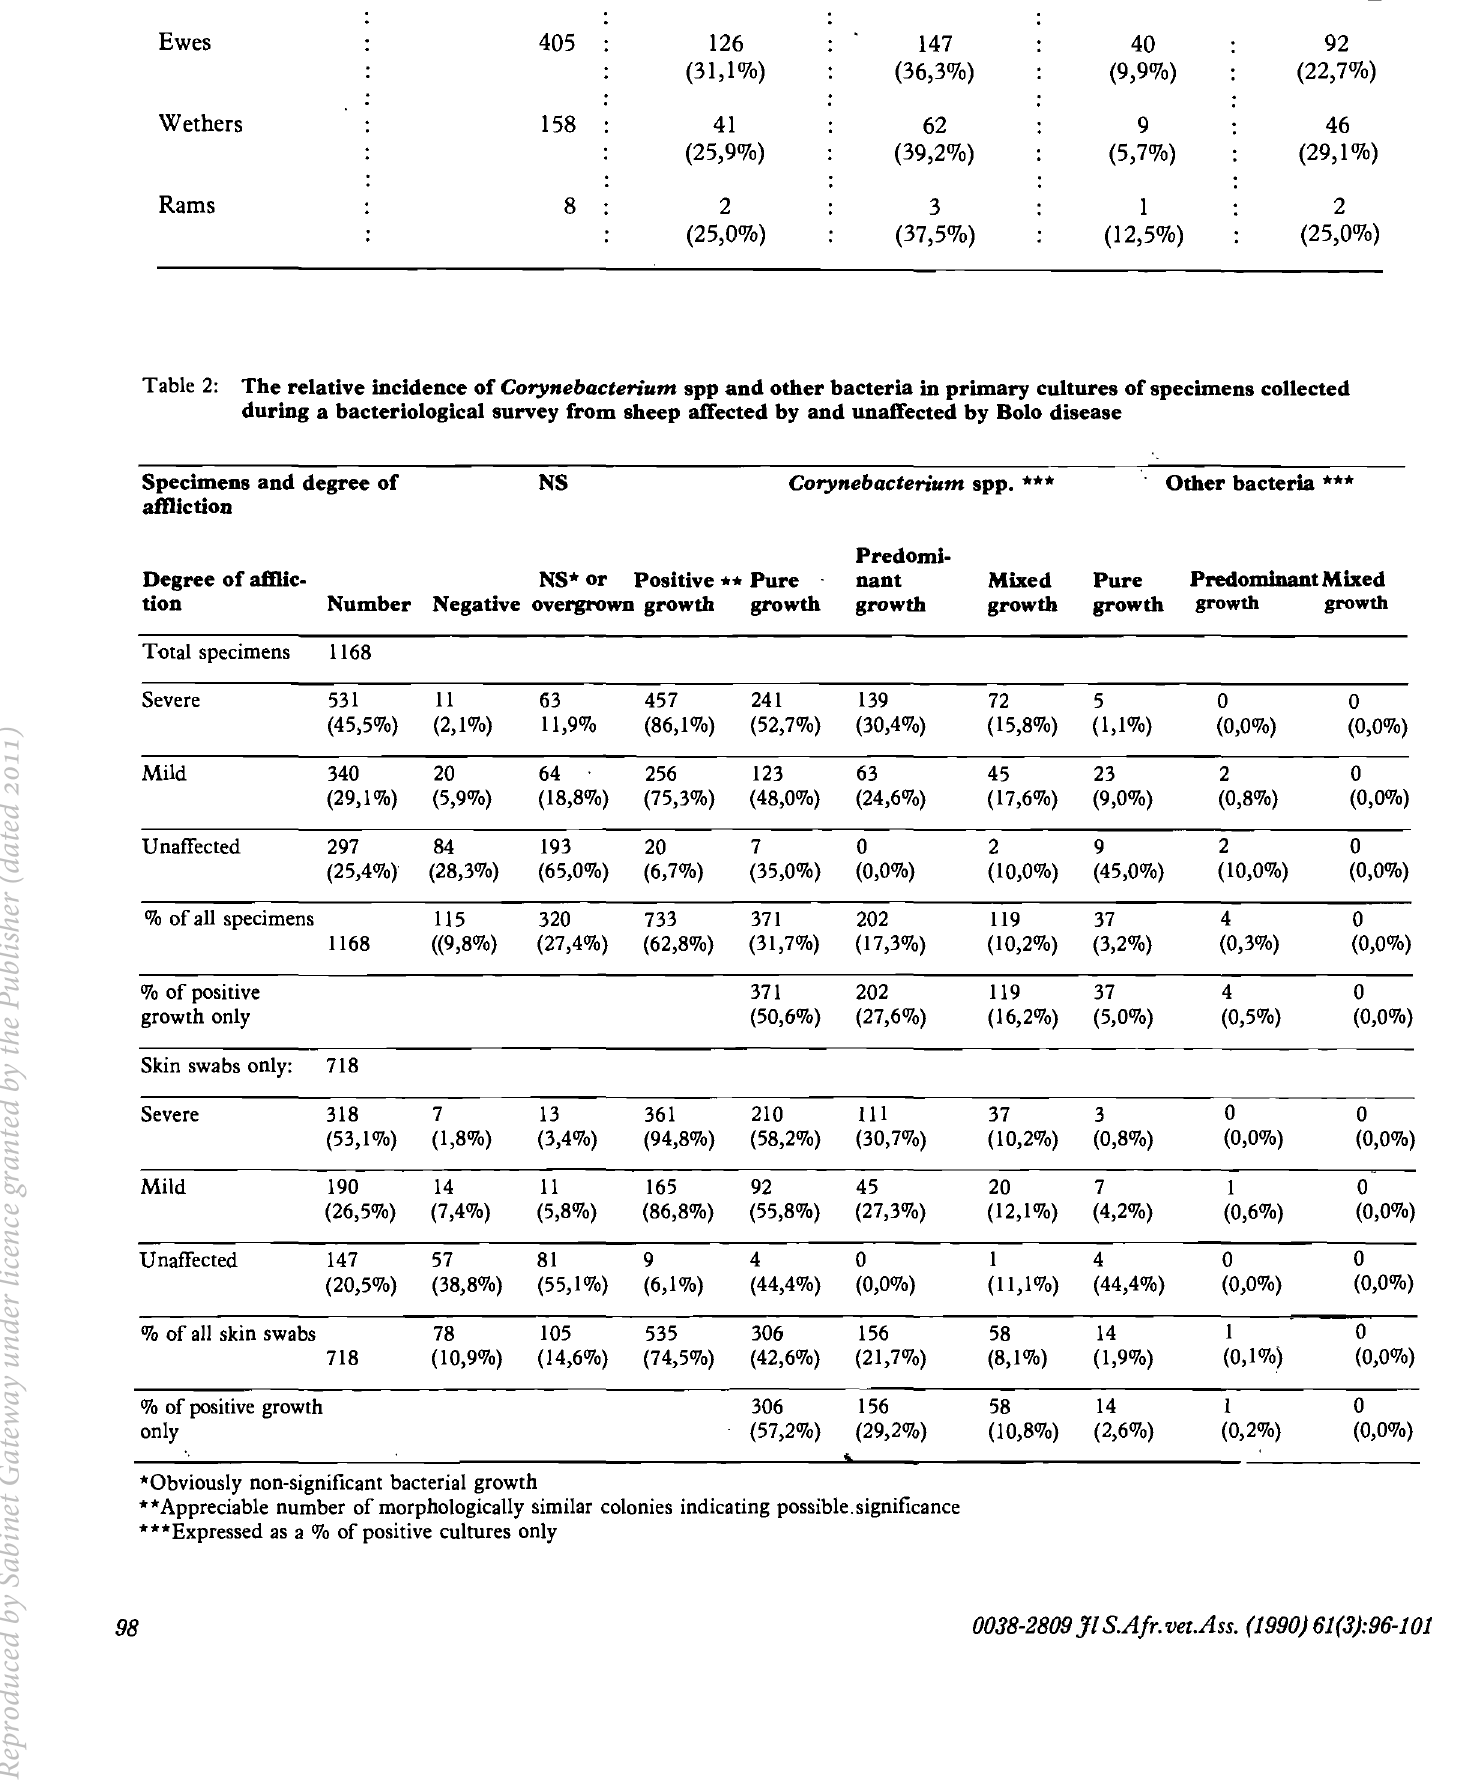
Table 1: Nature and distribution of lesions in sheep with Bolo disease examined during a